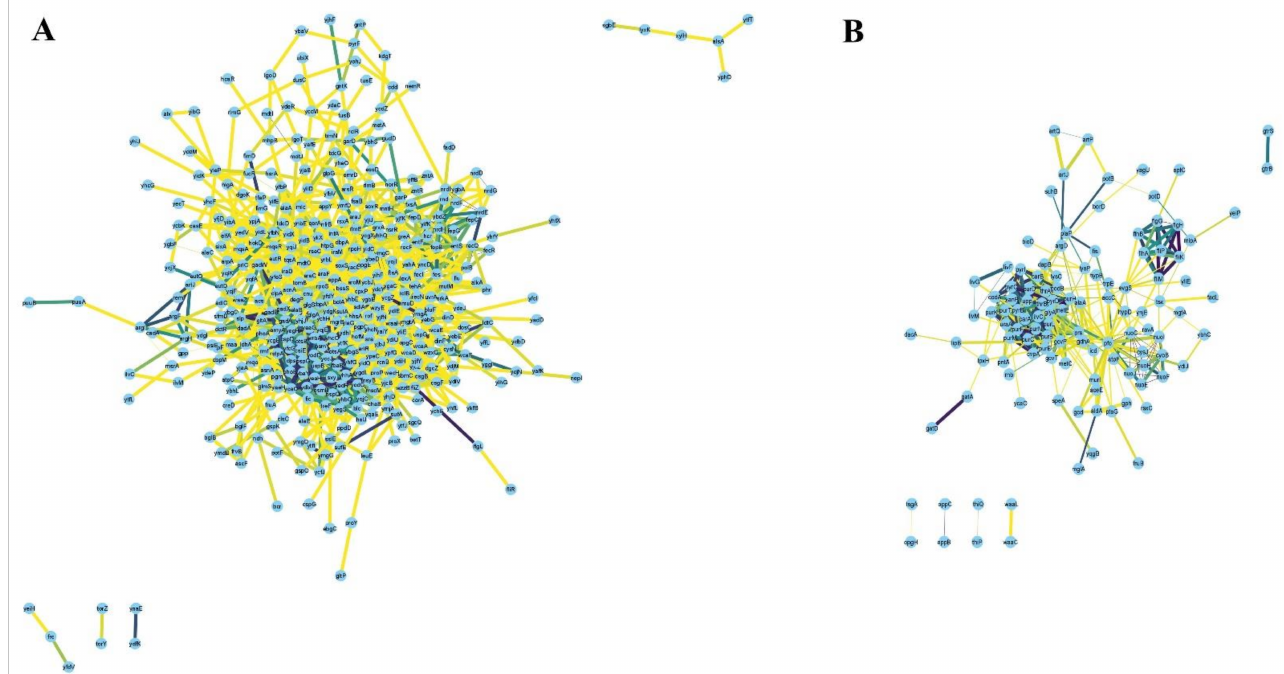
Figure 5. Network of ( A ) 461 upregulated genes in at least three stressors, and ( B ) 127 downregulated in at least four stressors with medium confidence (cut-off score: